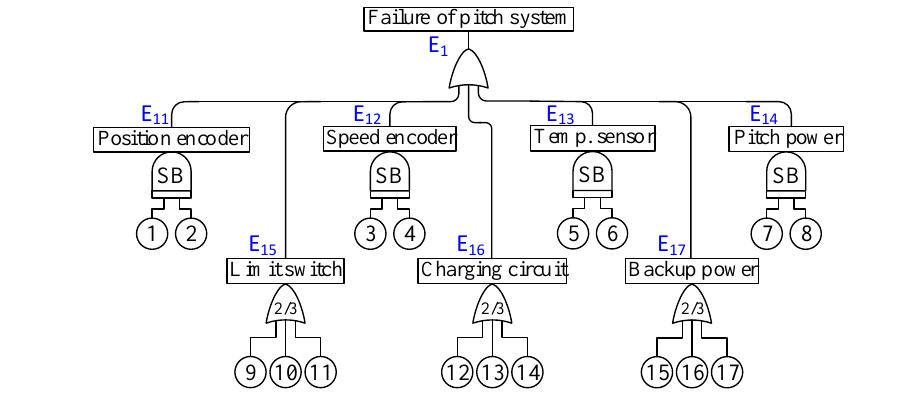
Figure 2. Fault tree of the pitch system.